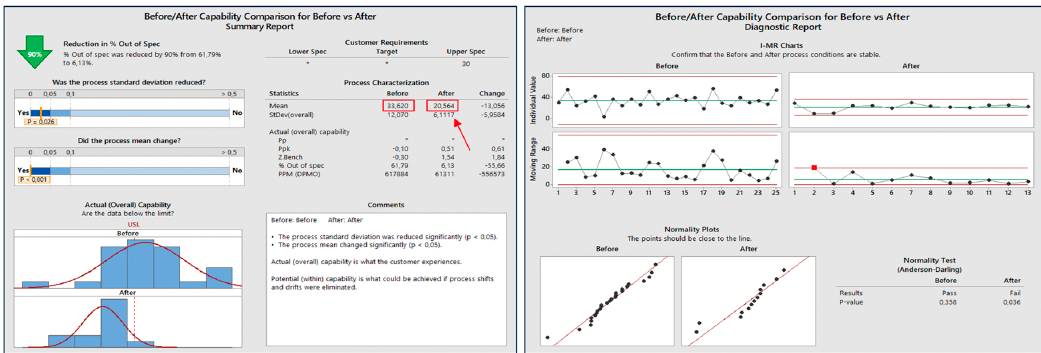
Figure 10. Weekly unscheduled breakdowns decrease.